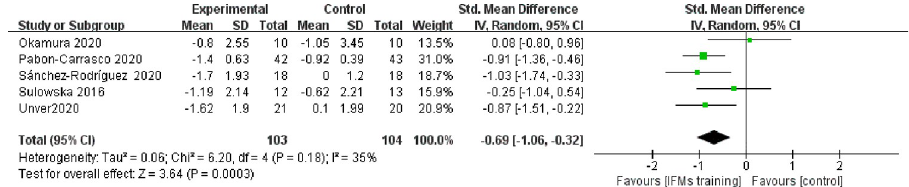
Fig 3. Forest plot illustrating foot posture index of meta-analysis comparing IFMs training with control group.